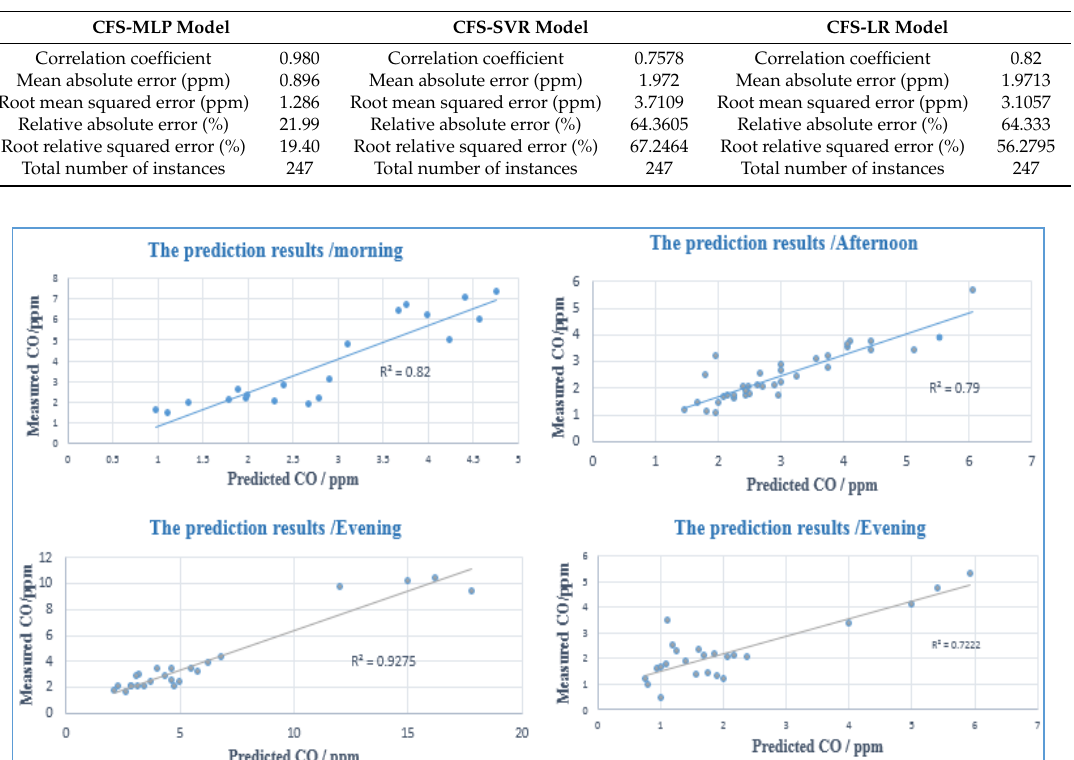
Table 8. The comparison between CFS-MLP, CFS-SVR and CFS-LR models.